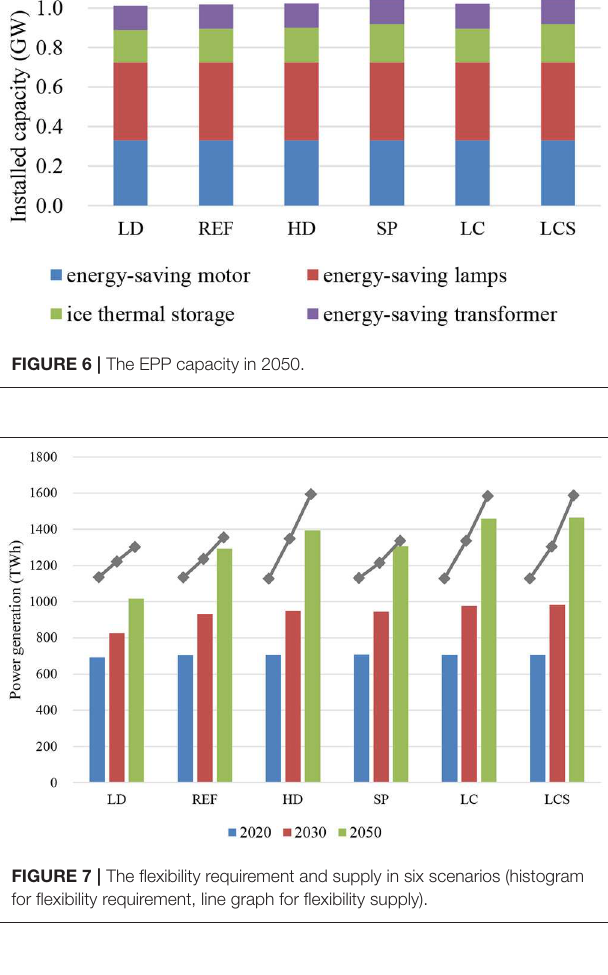
incorporated in SP and LCS scenarios on a large scale. In